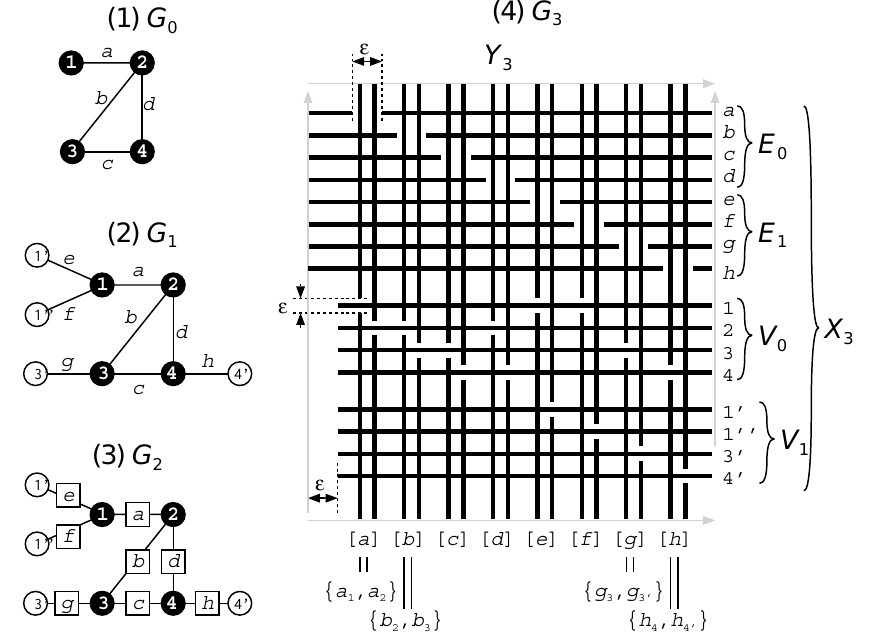
Fig. 2: Reductions from G 0 to G 1 , from G 1 to G 2 , and from G 2 to G 3